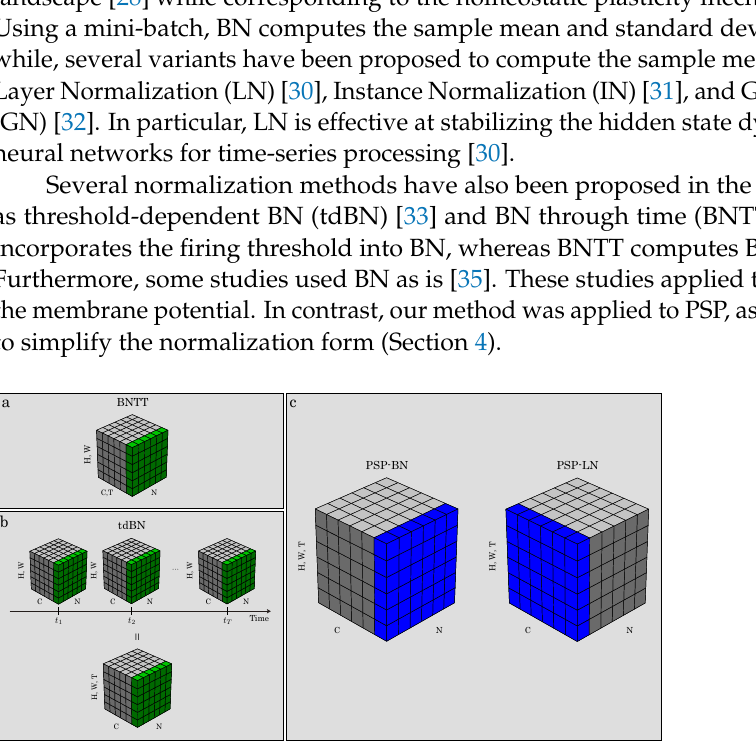
Figure 2. Normalization methods for spiking neural networks (SNNs). Each subplot shows a feature map ( a , b ) or post-synaptic input ( b ) tensor, with N as the batch axis, C as the channel axis, (H, W) as the spatial axis, and T as the time axis in the figure. Green voxels ( a , b ), previous methods, and blue ( c ), our proposed method, are normalized by the same second central moment and uncentered second moment,